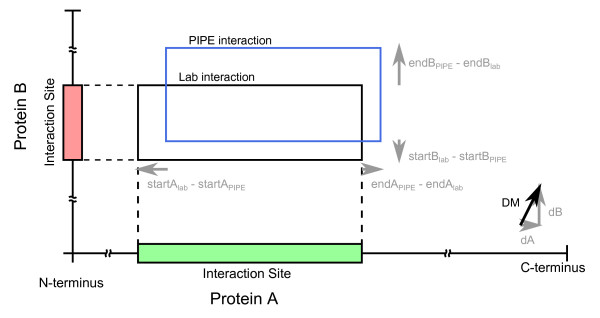
Distance measure (DM) calculation. Along each protein, the distance is the maximum difference between start and end positions (startAlab - startAPS, endAlab - endAPS). When the predicted site is contained within the lab site, the differences are both negative and we clamp the maximum difference at 0 (perfect match). Distances along each protein are scaled and combined vectorially to yield the DM.